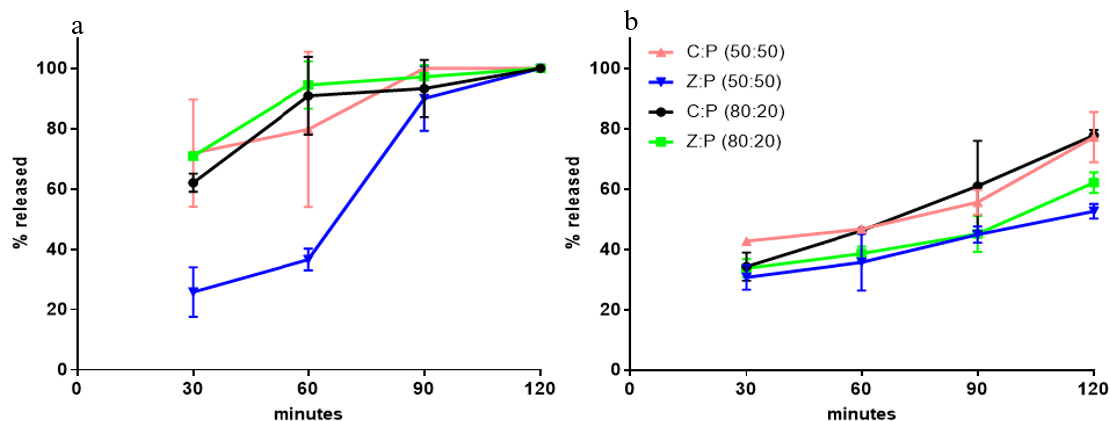
Figure 1. Ca 2 + fraction released from granules immersed in simulated gastric fluid (SGF): ( a ) size, 0.9 mm; ( b ) size, 1.2 mm.